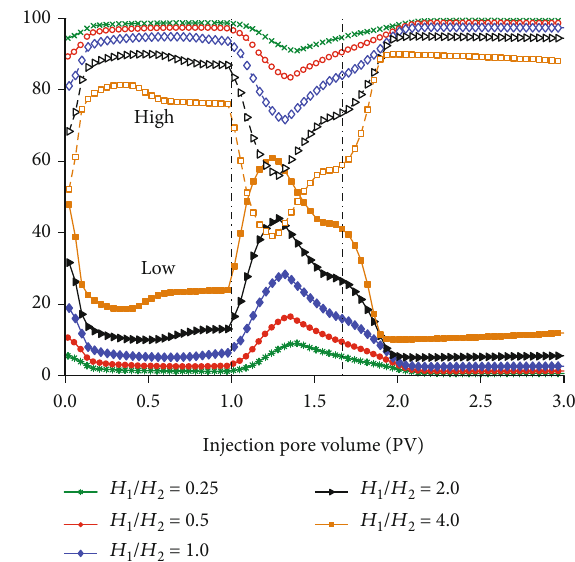
Figure 9: Injection conformance behavior for reservoirs with di ff erent net thickness ratios of low to high permeable